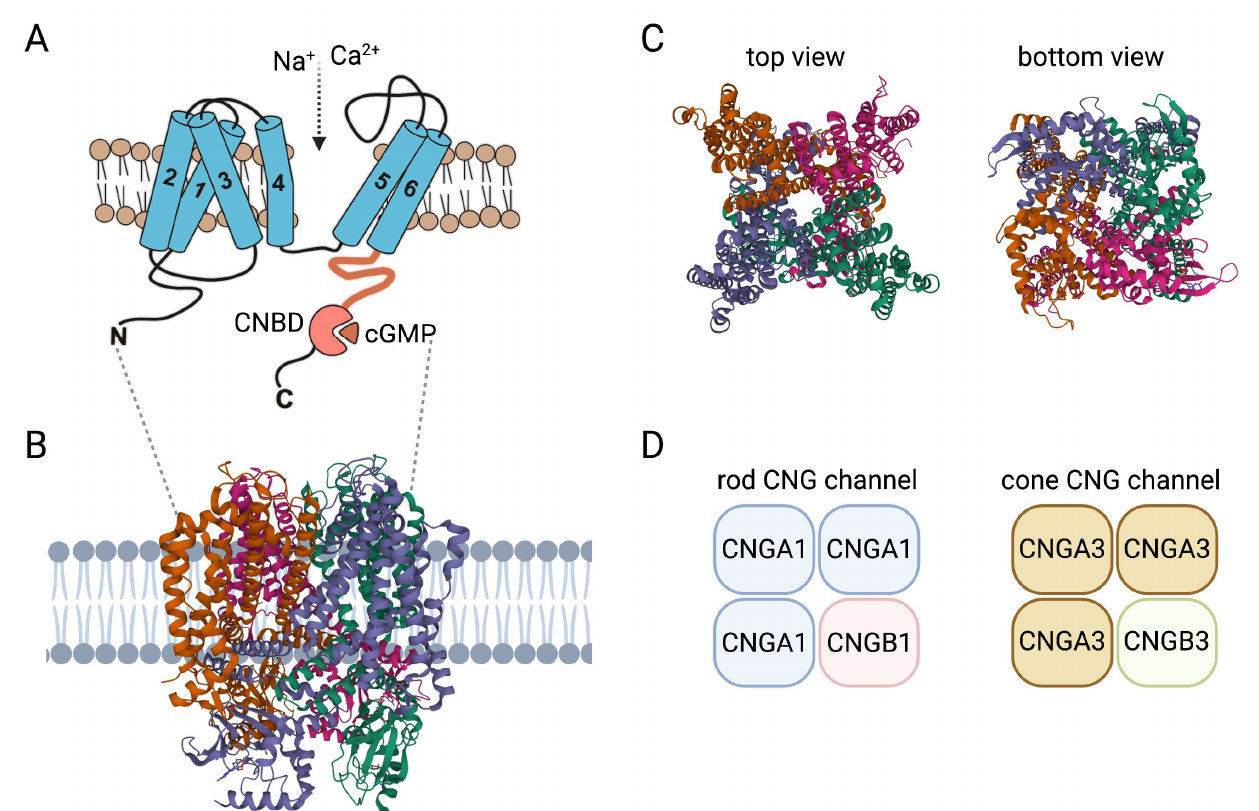
Figure 1. Structure and activation of CNG channels. ( A ) Membrane topology of CNG channel subunits: 1–6, transmembrane segment 1–6; C, carboxy-terminus; CNBD, cyclic nucleotide-binding domain; N, amino-terminus. ( B ) Model of the CNG channel complex embedded in the plasma membrane based on the human rod CNGA1/CNGB1 channel structure (PDB 7RHH). ( C ) Top and bottom views of the heterotetrameric human rod CNGA1/CNGB1 channel complex. ( D ) Subunit composition of the CNG channels from rods and cones. Structures in this figure were generated with the RSCB PDB 3D View tool (www.rcsb.org/3d-view/ accessed on 19 Dec 2022) based on PDB 7RHH.